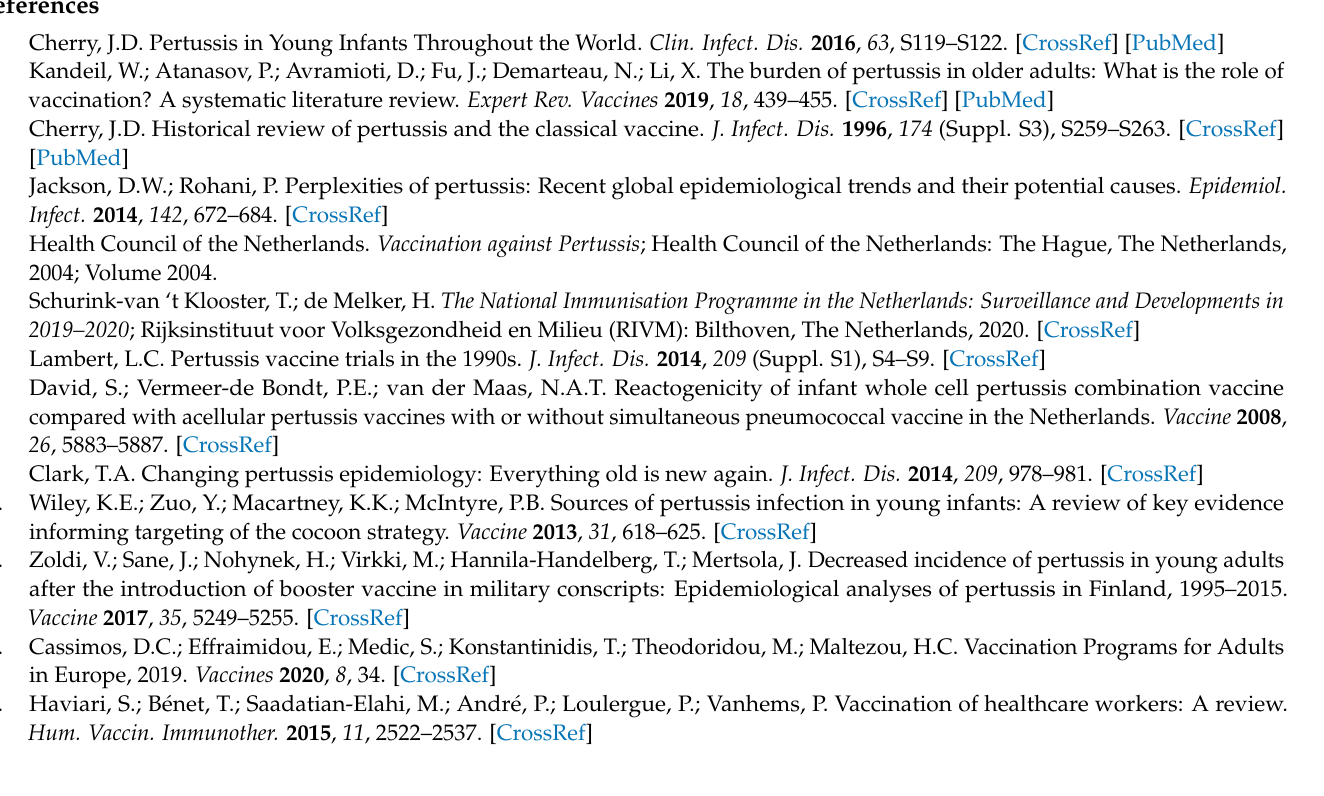
cohorts; Figure S2: Cumulative local pertussis disease notifications; Figure S3: Individual antibody concentrations; Table S1: B. Pertussis vaccine schedules and vaccines in the